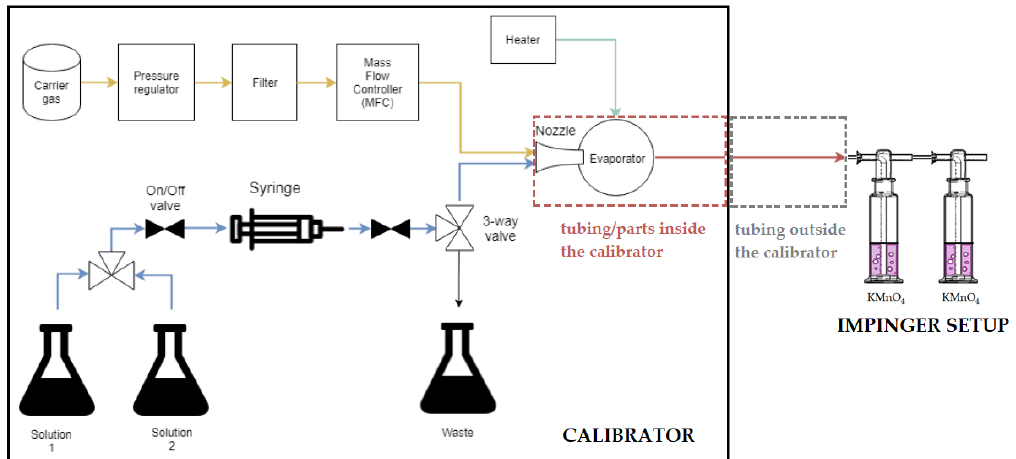
Figure 3. The scheme of the adsorption evaluation setup. Dashed lines show the parts of the setup where the adsorption was evaluated. Adsorption on the tubing/instrument parts inside the calibrator is marked by the red dashed lines, while adsorption on the tubing outside the calibrator is marked by grey dashed lines.